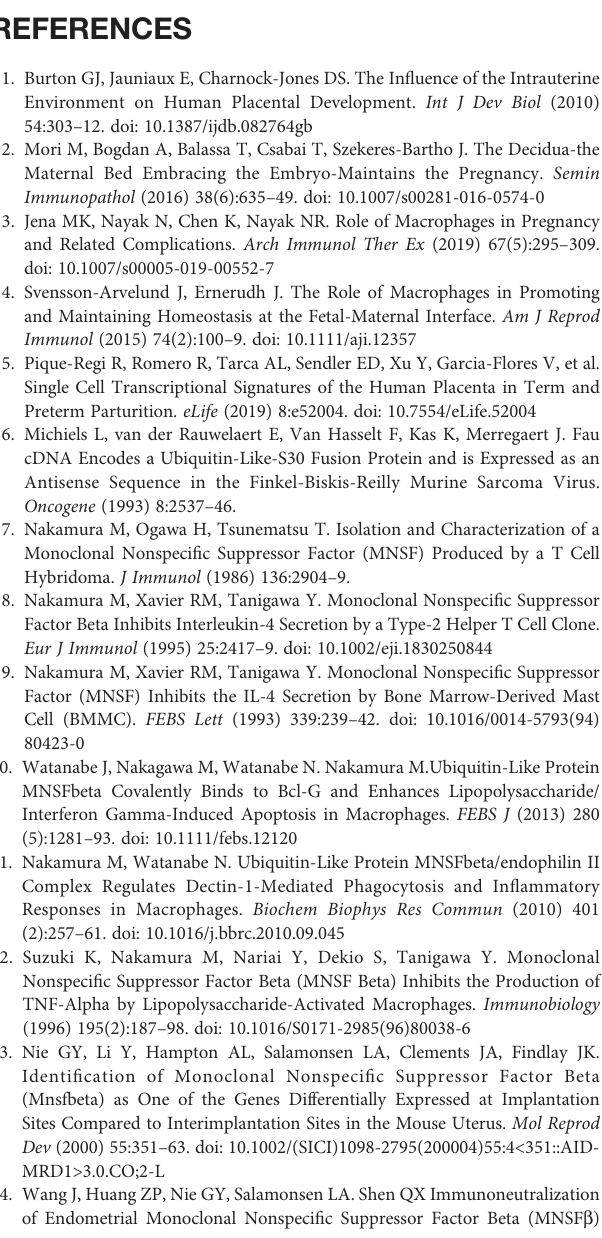
Supplementary Table S2 | Sequence of Primers used in Real-time RT-PCR. Supplementary Table S3 | Information of Antibodies Used in This Study. Supplementary Table S4 | Proliferation of T-HESCs by Cell Viability